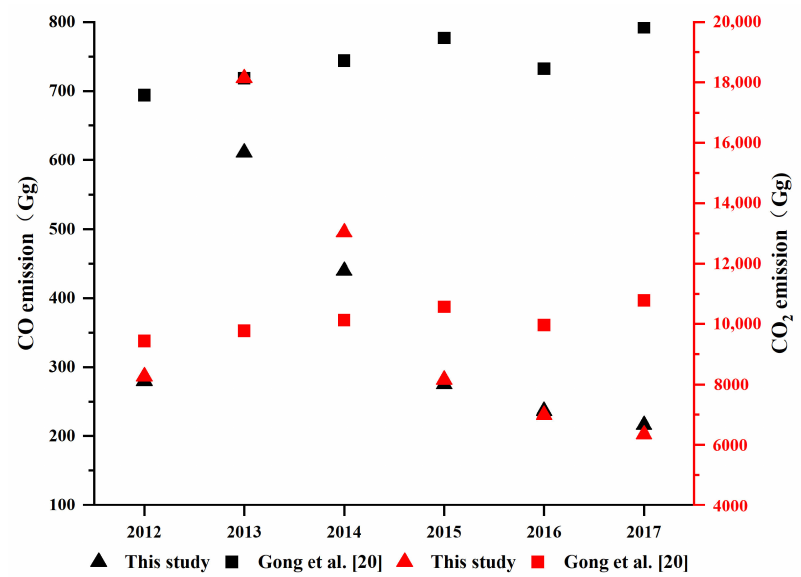
Figure 7. Comparison with the results of Gong et al.